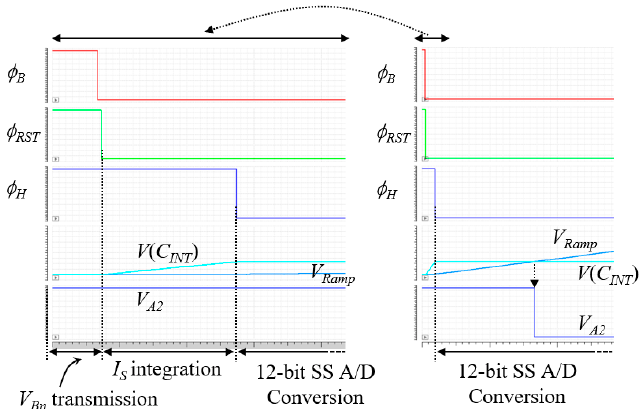
Figure 9. Simulated waveforms for the operation mode of the unit cell circuit.